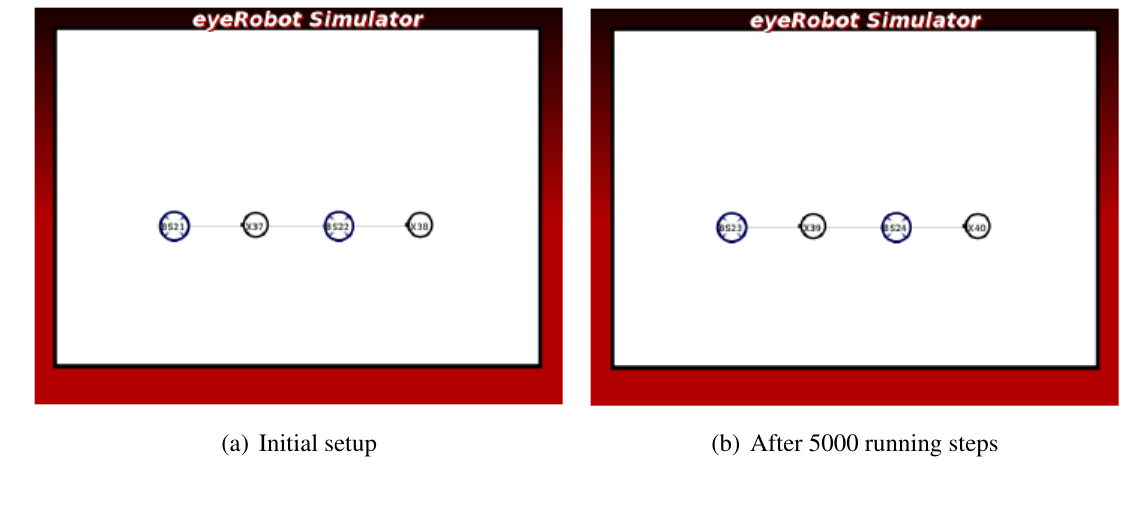
Figure 14. The experiment of the Isolated scenario.